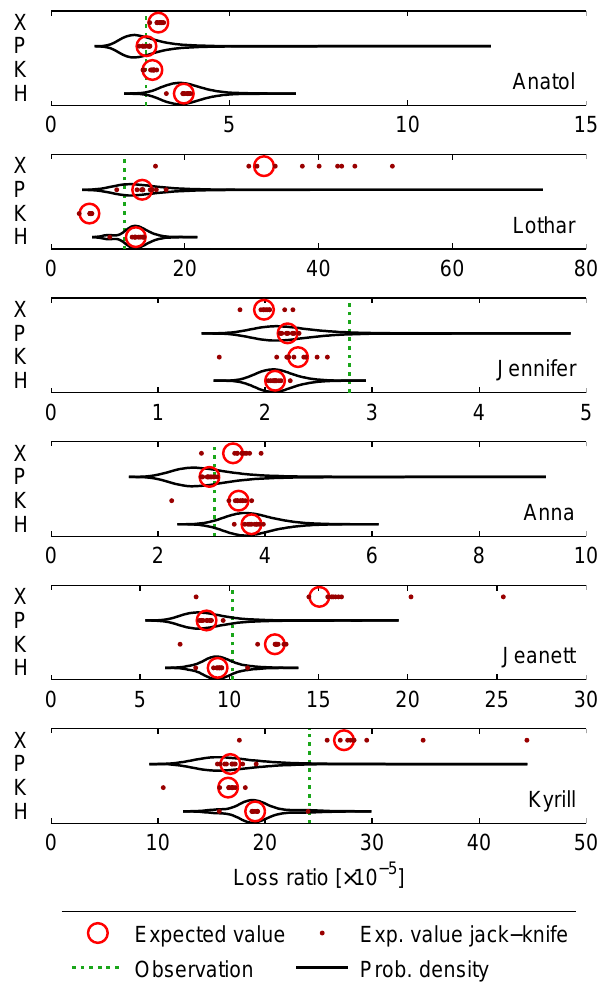
Figure 5. Model estimates for the six most severe winter storms in the period 1997–2007 based on DWD data. Red circles indicate the expected value obtained from models trained on the full 10- year data, while the red dots represent expected values from the 9- year resampled (jackknife) training periods. For models P and H , the black contours represent the probability distribution of predicted storm loss for the 10-year training data. Empirical insured loss is marked by green dashed